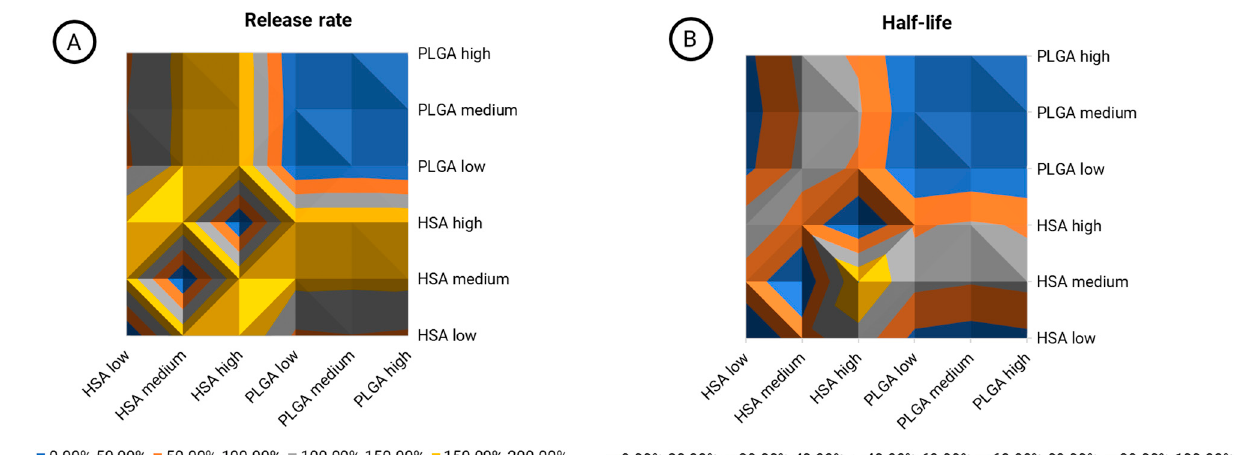
Figure 6. Inequivalence contour map indicating the relative (percentage) difference between formula-